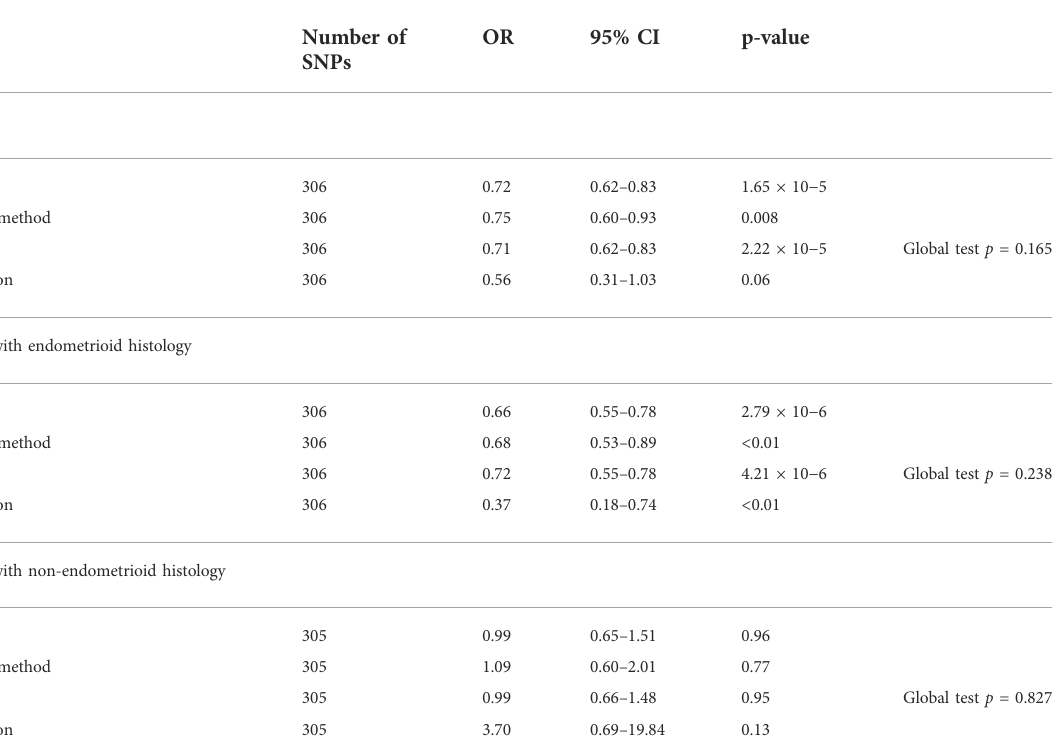
TABLE 1 Causal effect from educational attainment to endometrial